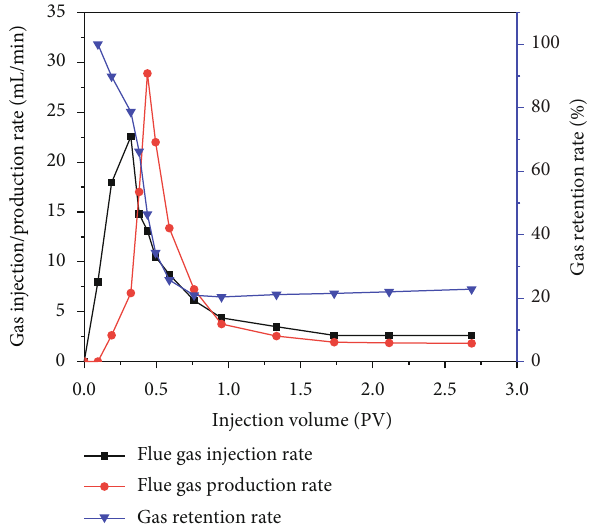
Figure 9: Volume variation of produced gas in fl ue-gas-assisted steam fl